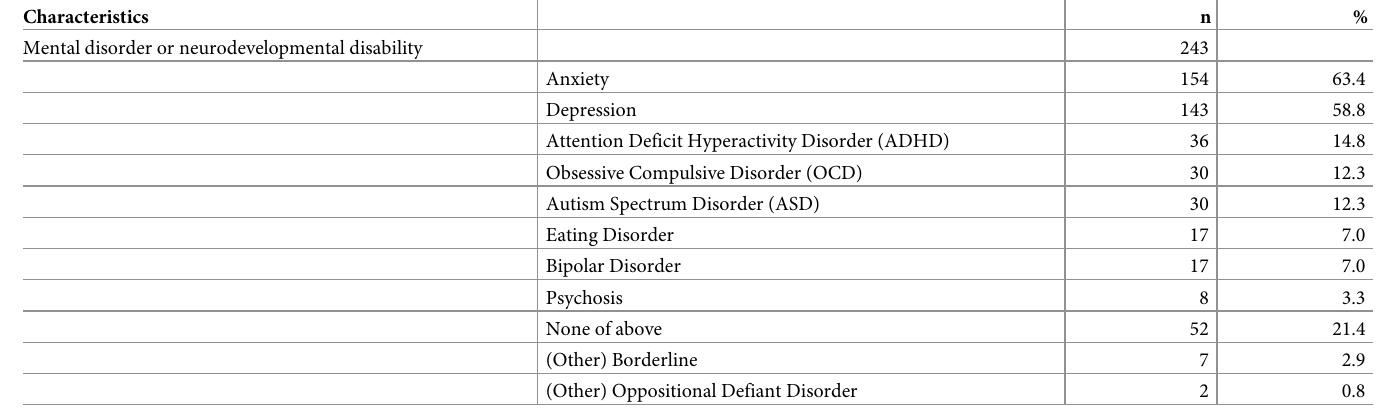
Table 9. AYA Cumulative mental disorder and neurodevelopmental disability diagnoses.